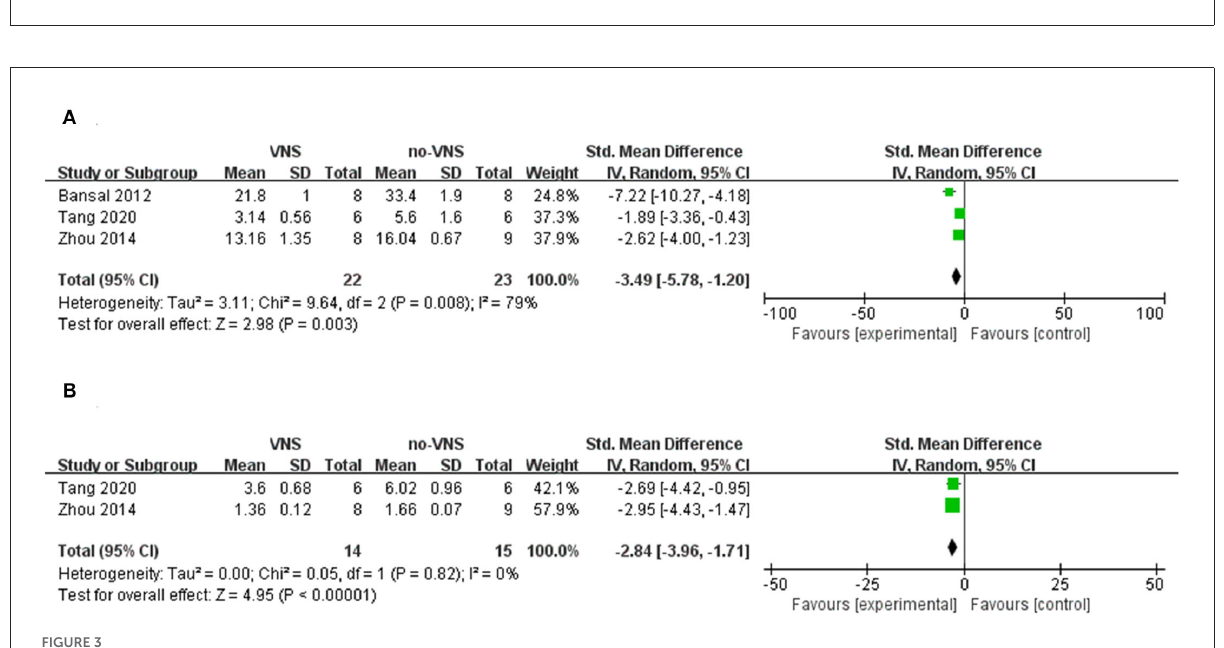
and reduce TNF in brain injury by upregulating the expression of peroxisome proliferator-activated receptor γ (PPAR γ )